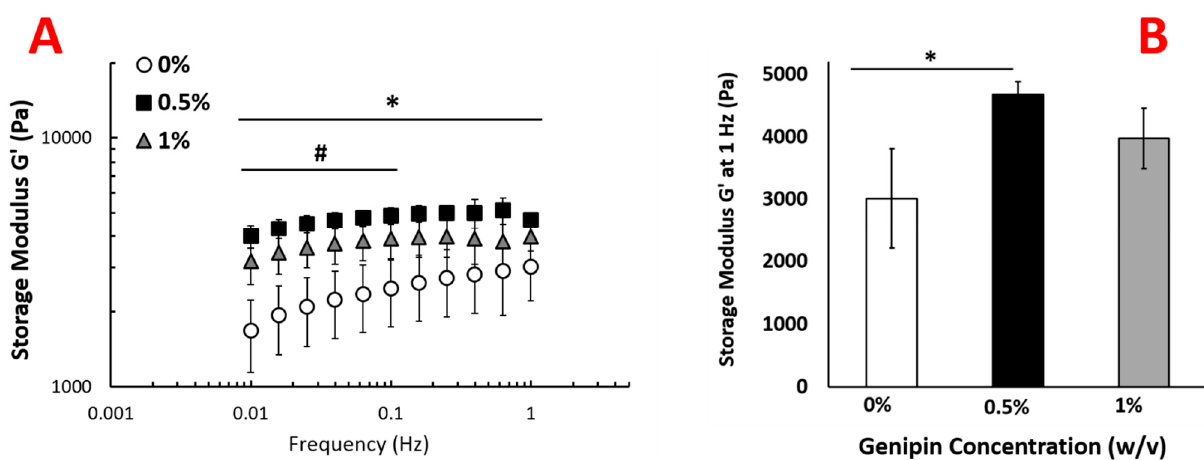
Figure 4. Rheological analysis of genipin crosslinked scaffolds ( A ) The changes in the storage modulus as a function of frequency for scaffolds crosslinked with various genipin concentration (0%, 0.5%, and 1% ( w / v )). ( B ) Storage modulus at 1 Hz as a function of genipin concentration. Six samples were used for each group ( n = 6). (#) denotes a significant difference between frequencies, while (*) indicates a significant difference between sample groups, p < 0.05.